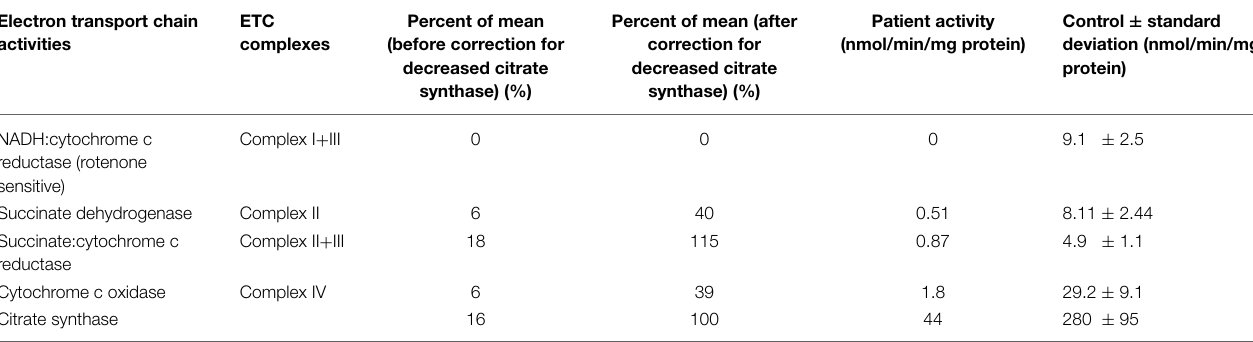
TABLE 1 | Muscle mitochondrial respiratory chain enzyme activity